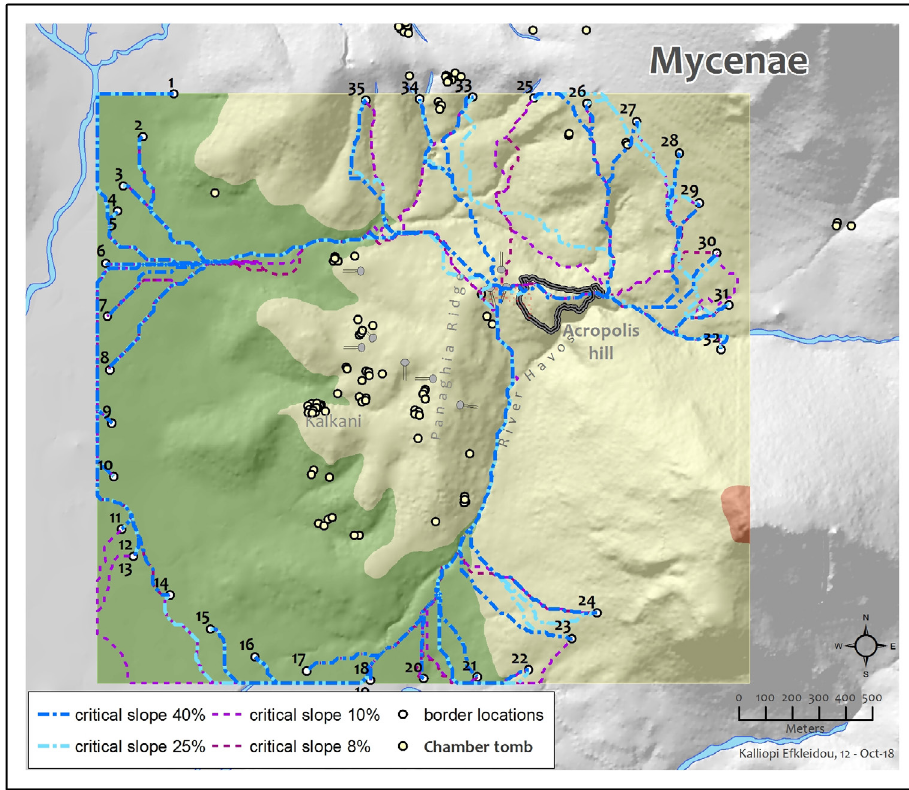
Figure 5. Universally optimal LCPs based on different critical slope rasters originating from the Acropolis of Mycenae. The routes coincide up to a certain point only in the case of destination points to the west and to the south of the Acropolis. What is also interesting is the fact that none of the optimal paths crosses the main area of Mycenae’s mortuary landscape. Detour seems to be the keyword here, leading to the possible conclusion that most of from the town of